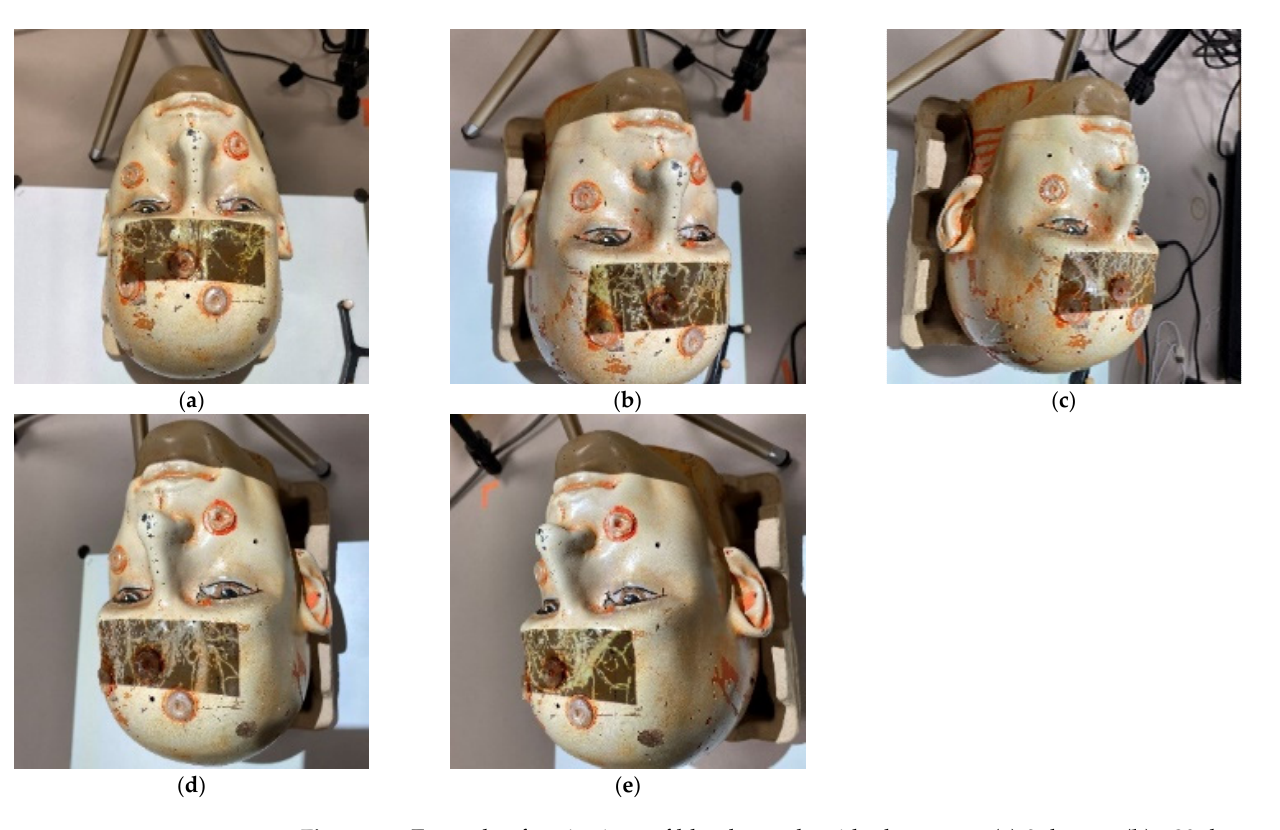
Figure 11. Example of projections of blood vessels with observer at ( a ) 0 degree, ( b ) +30 degrees, ( c ) +60 degrees, ( d ) − 30 degrees, and ( e ) − 60 degrees.